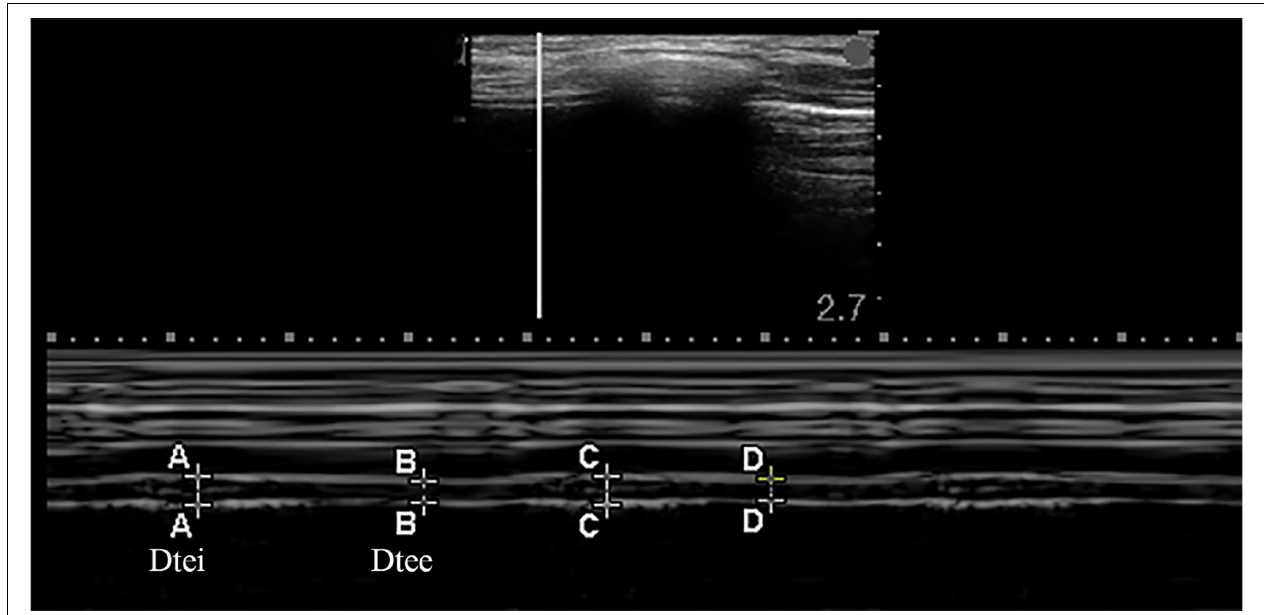
FIGURE 2 | Measurements of the diaphragm thickness by the ultrasound in M-mode. Dtee, diaphragm thickness at the end of expiration; Dtei, diaphragm thickness at the end of inspiration.